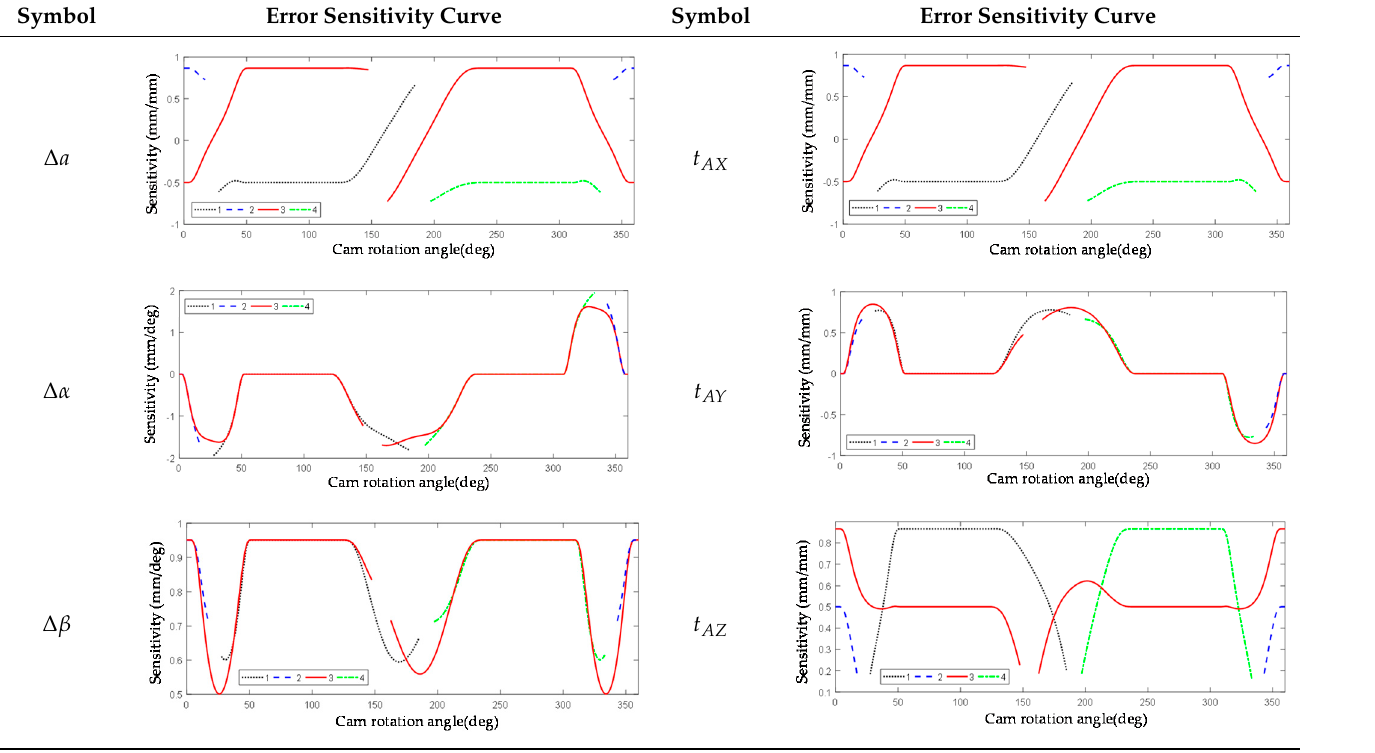
Table 3. Error sensitivity curve.